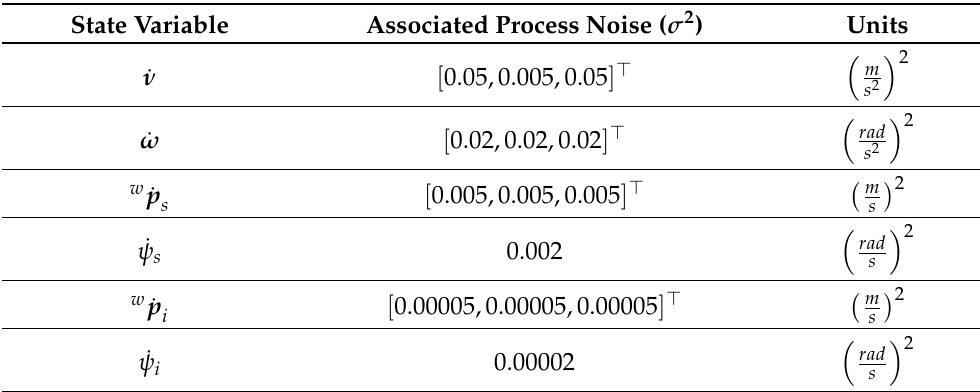
Table 2. Kinematic process model noise